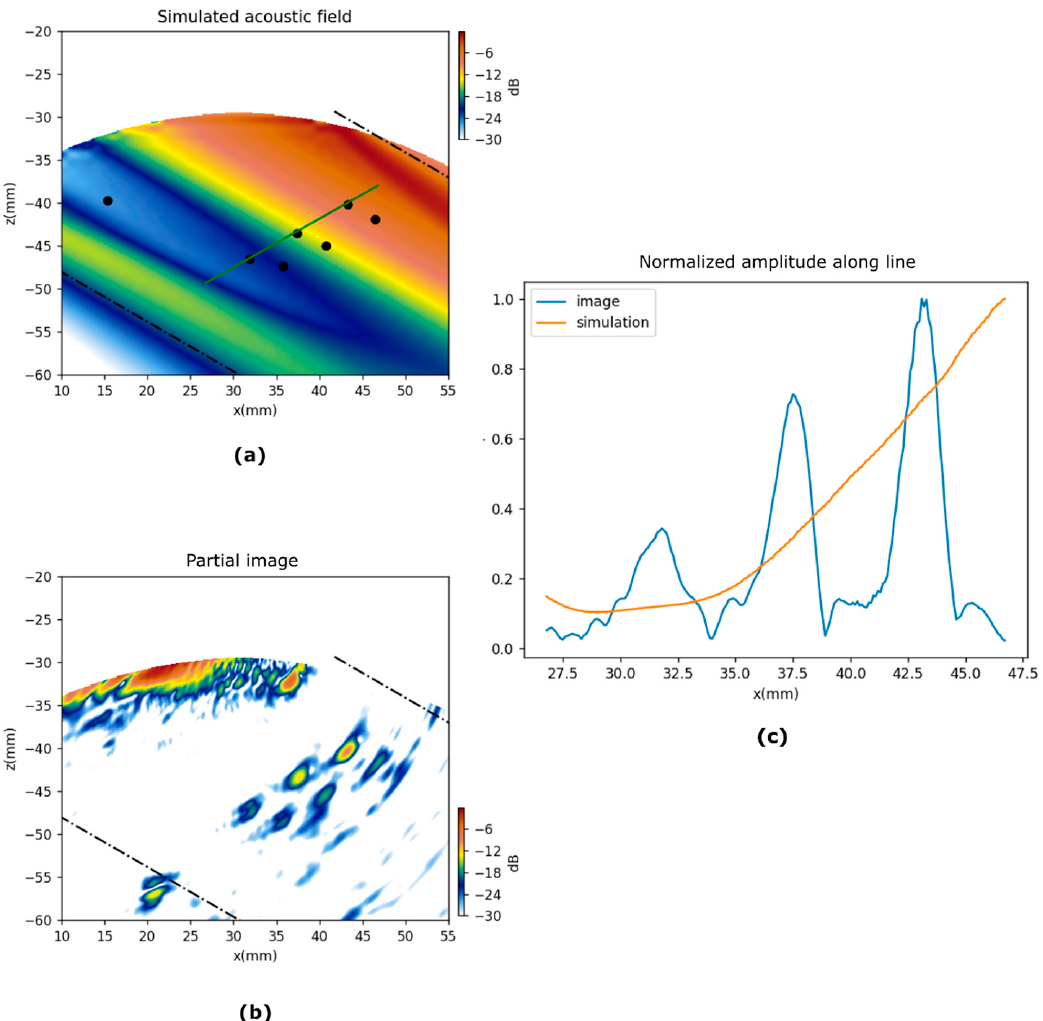
Figure 10. Simulation and partial PWI images for emission at 60°, test piece A. ( a ) Simulated acoustic field, the dots represent the holes. ( b ) Partial PWI image. ( c ) Amplitude along the green line in ( a ).